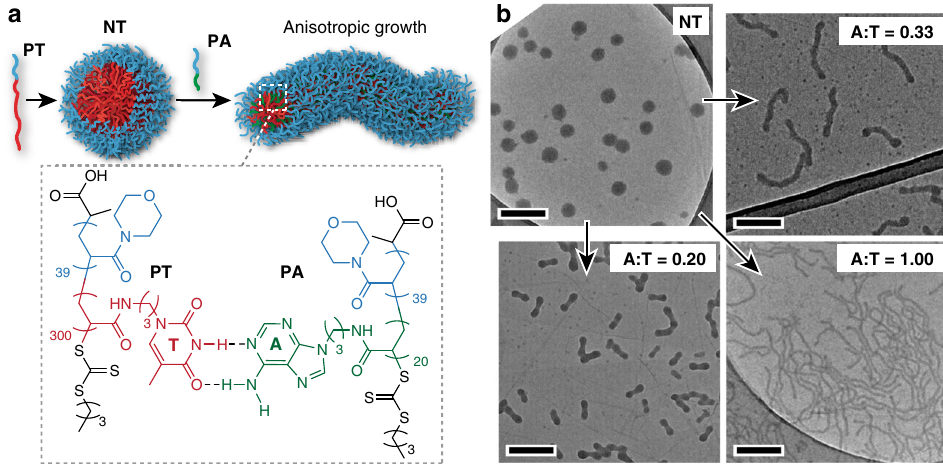
Fig. 2 Single-step transformation of spherical nanoparticles into different anisotropic morphologies by MORPH. a Schematic representation of MORPH using nucleobase-containing polymers. Spherical nanoparticle NT with a thymine-containing core was formed by self-assembly of the polymer PT using a solvent switch method from DMF to water. Introduction of the adenine-containing polymer PA induced MORPH at A:T molar ratios above 0.20. b TEM images of the nanoparticles formed before and after addition of PA at different A:T molar ratios to separate solutions of NT . Particles were imaged stain- free on graphene oxide (GO) 46 . Scale bars = 200